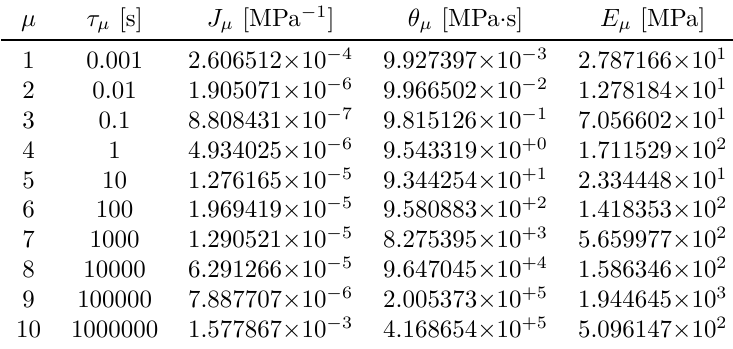
Table 2. Parameters of Maxwell chain